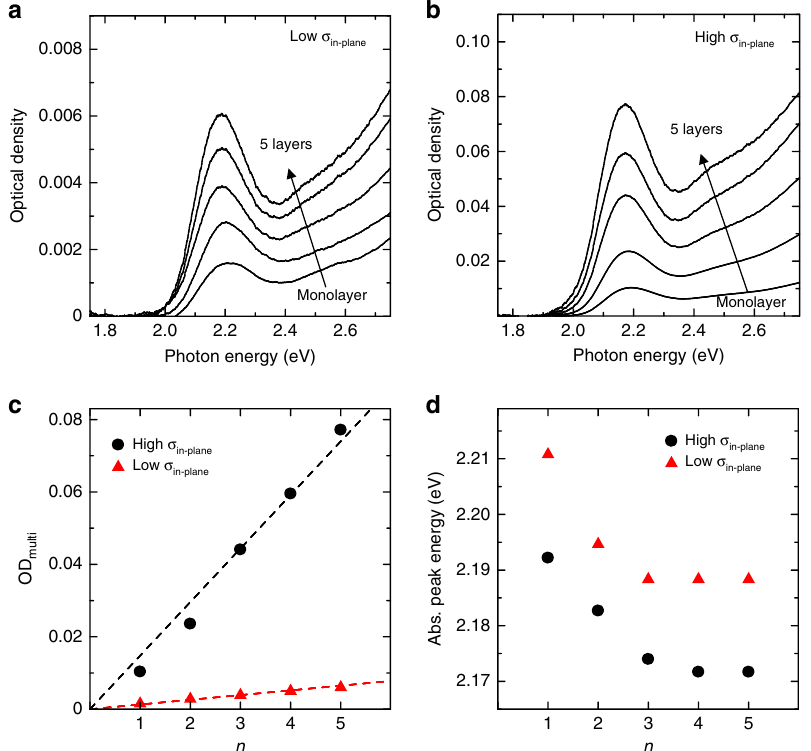
Fig. 4 Absorption properties of quantum dot multilayers. a , b Absorption spectra of the CdTe quantum dot multilayers with a low and b high in-plane quantum dot density ( σ in-plane ). c Optical density of the absorption peak of the multilayers (OD multi ) versus the number of layers ( n ). The dashed lines are proportional to n , which show that the OD multi are proportional to n . d Absorption peak energy of the multilayers versus n .